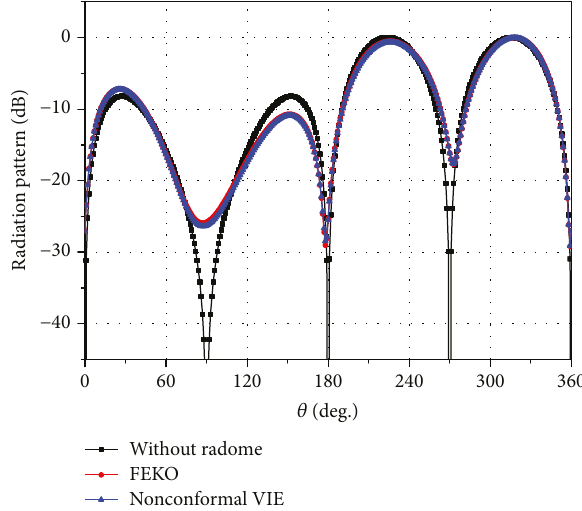
Figure 7: Normalized far- fi eld radiation pattern in the XOZ plane of a small 8-dipole array in a hemispherical radome.